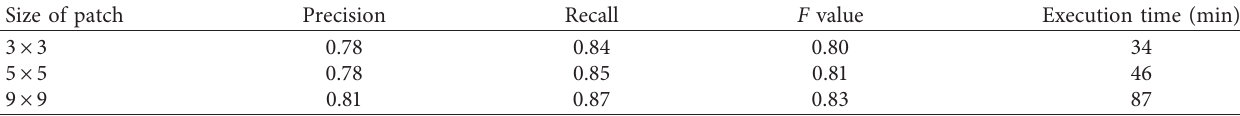
Table 14: Impact of patch size on influencing parameters.